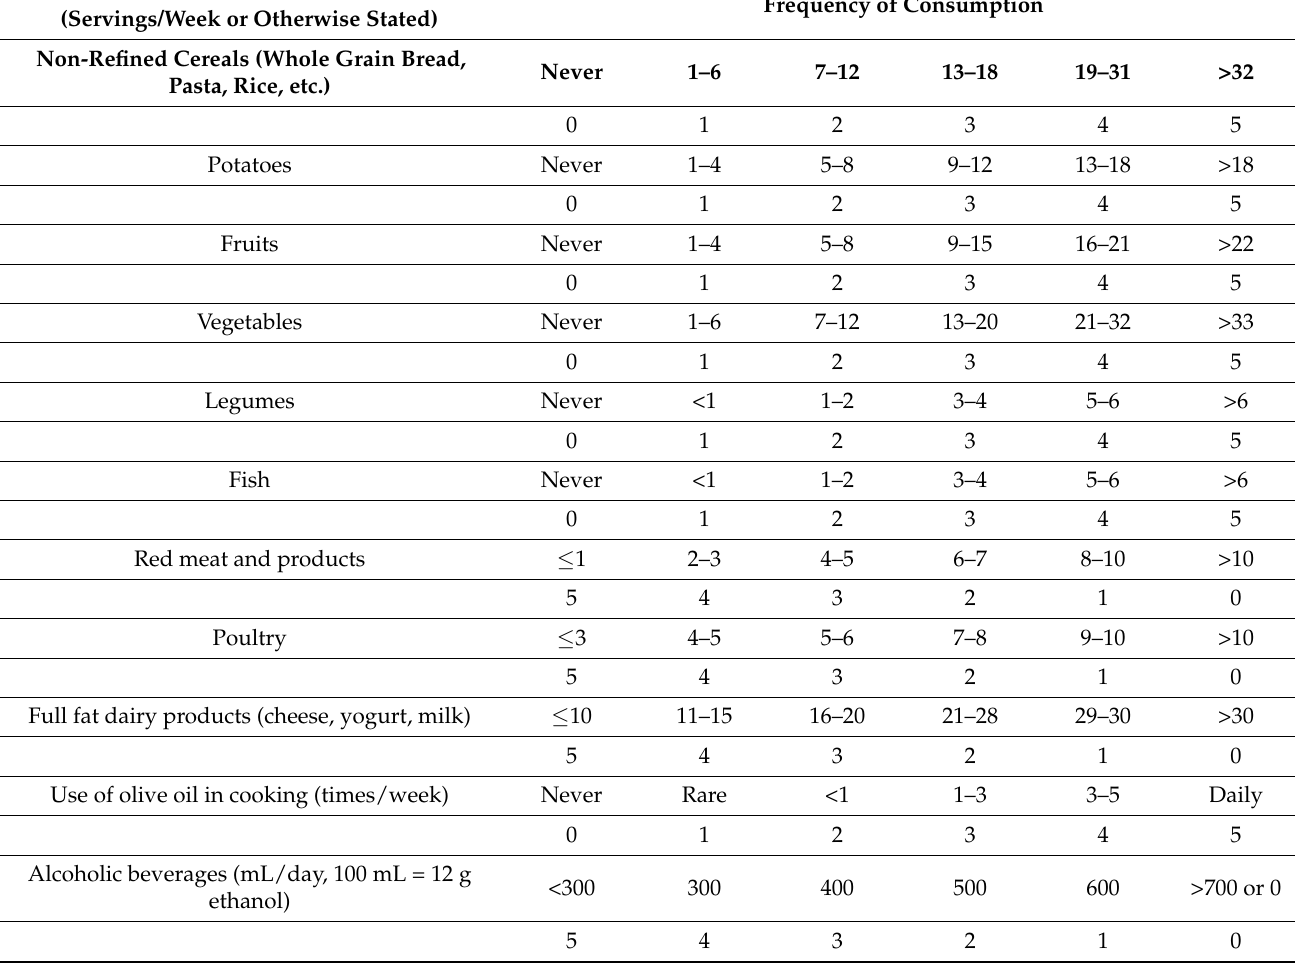
Table 1. The Mediterranean Diet